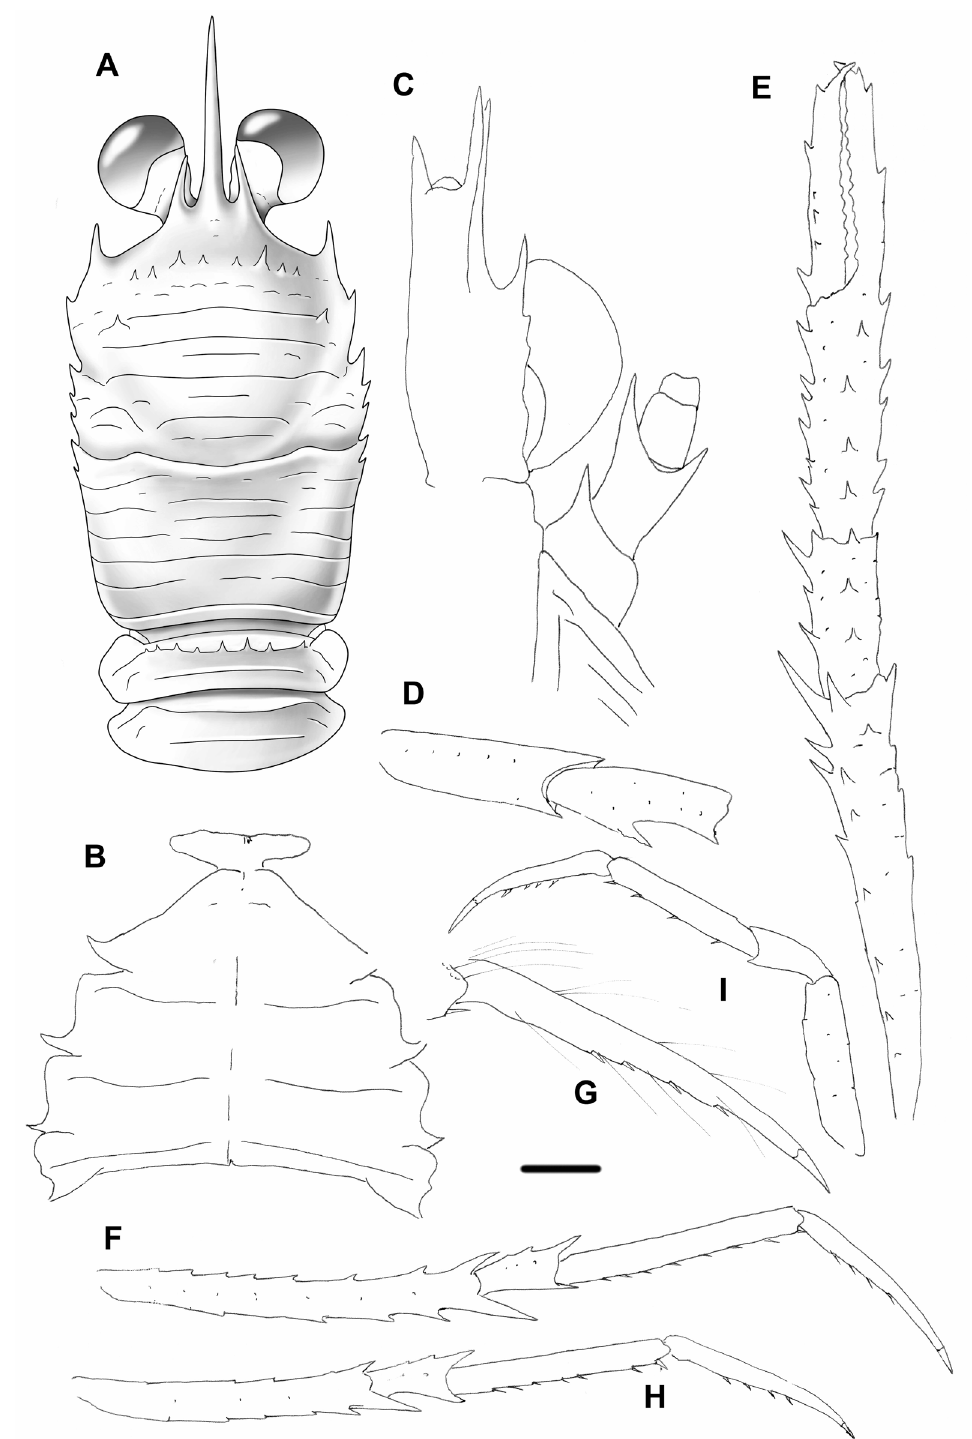
Fig. 5. Munida hoda sp. nov., holotype, ♂, 5.3 mm (MNHN-IU-2014-13479), Mozambique. A . Carapace and abdomen, dorsal view. B . Sternal plastron. C . Cephalic region, showing antennular and antennal peduncles, ventral view. D . Right Mxp3, lateral view. E . Right P1, dorsal view. F . Right P2, lateral view. G . Dactylus of right P2, lateral view. H . Left P3, lateral view. I . Left P4, lateral view. Scale bar: A, E–F, H–I = 1.0 mm; B–D, G = 0.5